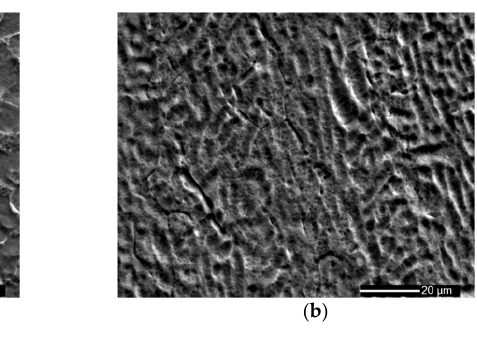
Figure 3. Cross section of the linear friction welding (LFW) joints with Ti64 and Ti17 alloys.